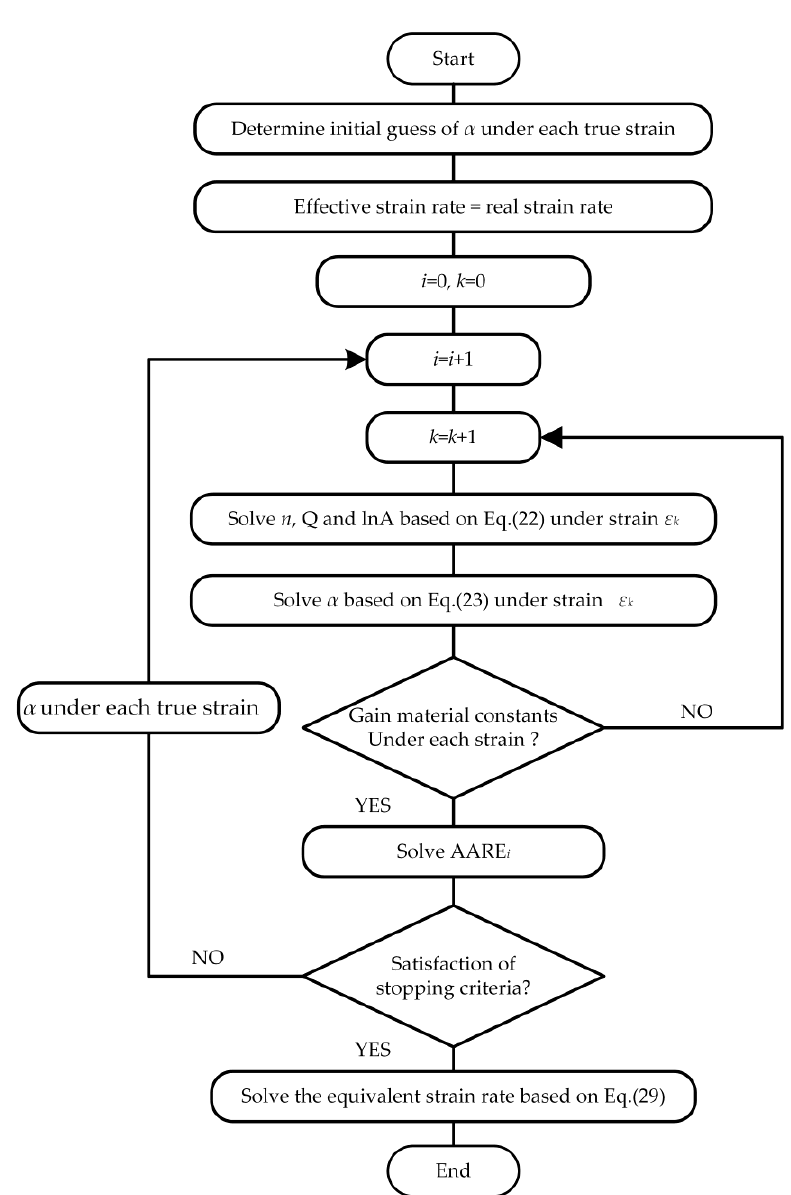
Figure 10. Flow chart of establishing the modified strain-compensated Arrhenius-type equation.